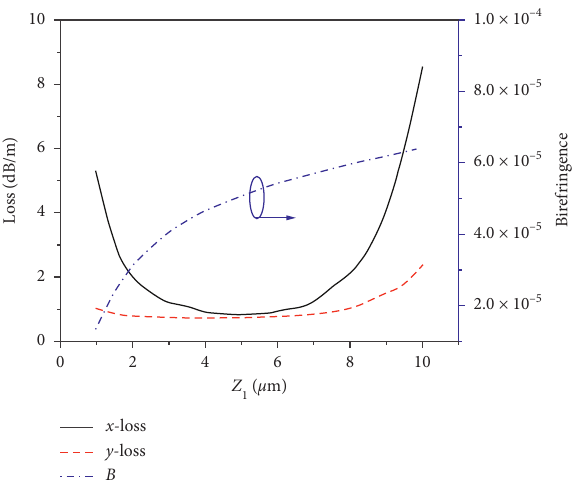
Figure 5: The loss of x and y polarization modes and birefringence as a function of Z